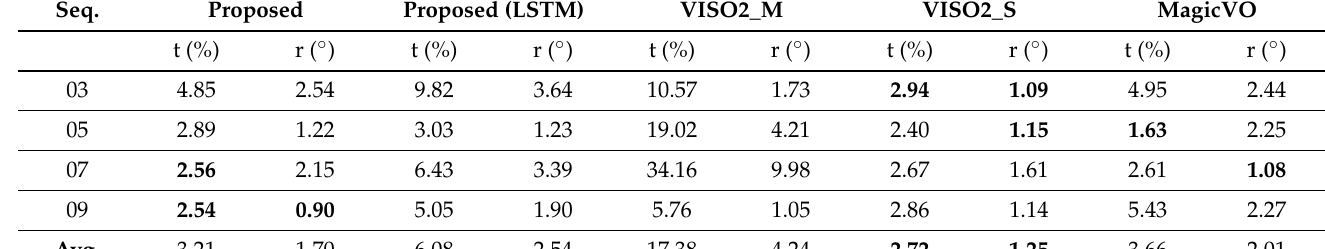
Table 2. Comparison of proposed method vs. monocular and stereo-based VISO2 and MagicVO. • t: average translation drift (%) on length of 100–800 m. • r: average rotation drift ( ◦ /100 m) on length of 100–800 m. Seq.